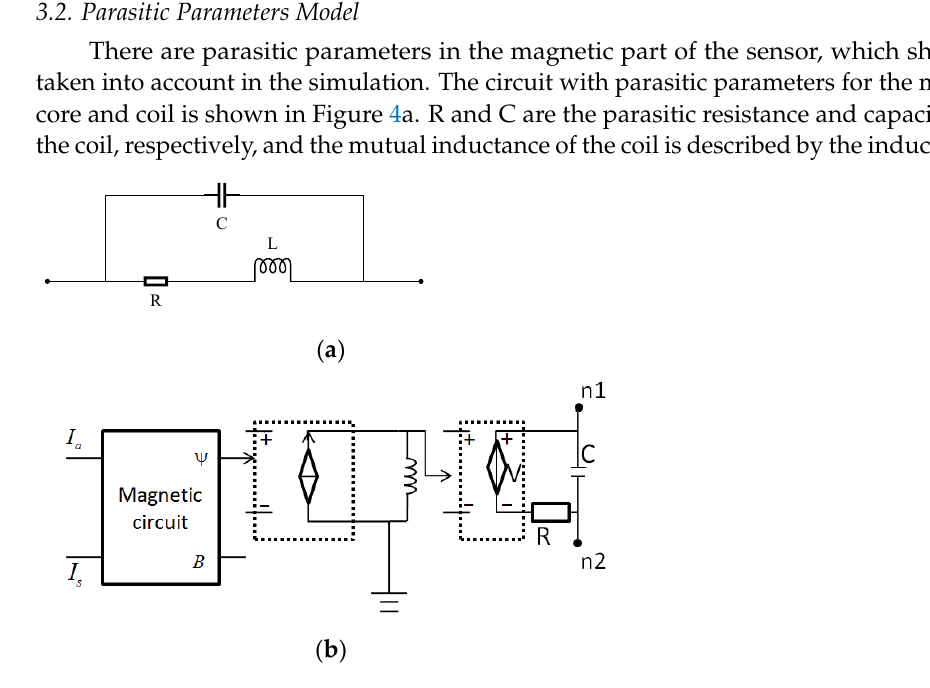
Figure 4. Parasitic parameters circuit. ( a ) Magnetic core and coil diagram; ( b ) Details of the mutual inductance.